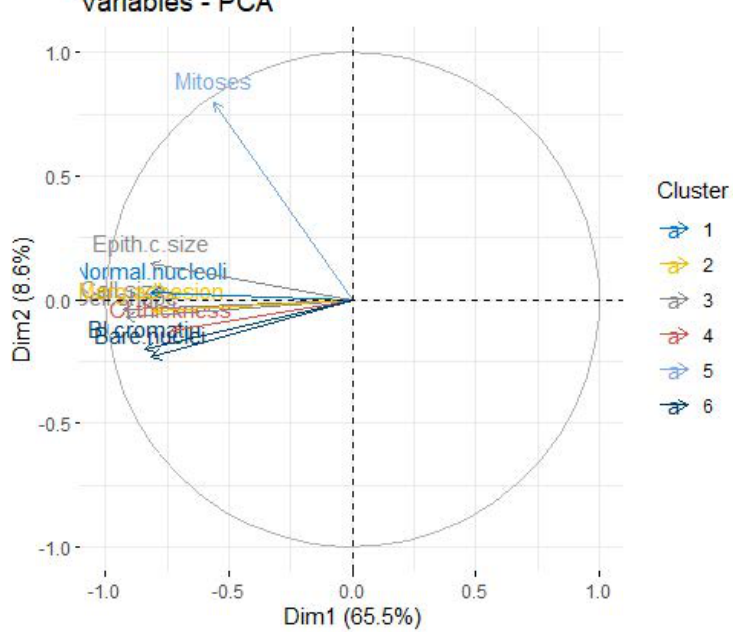
Figure 8. Variable PCA for the breast cancer data.